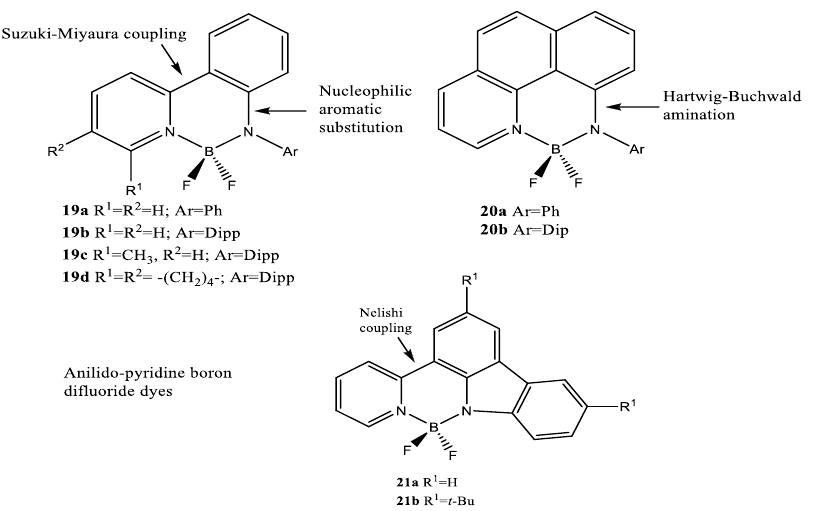
Molecules 2022 , 27 , x FOR PEER REVIEW